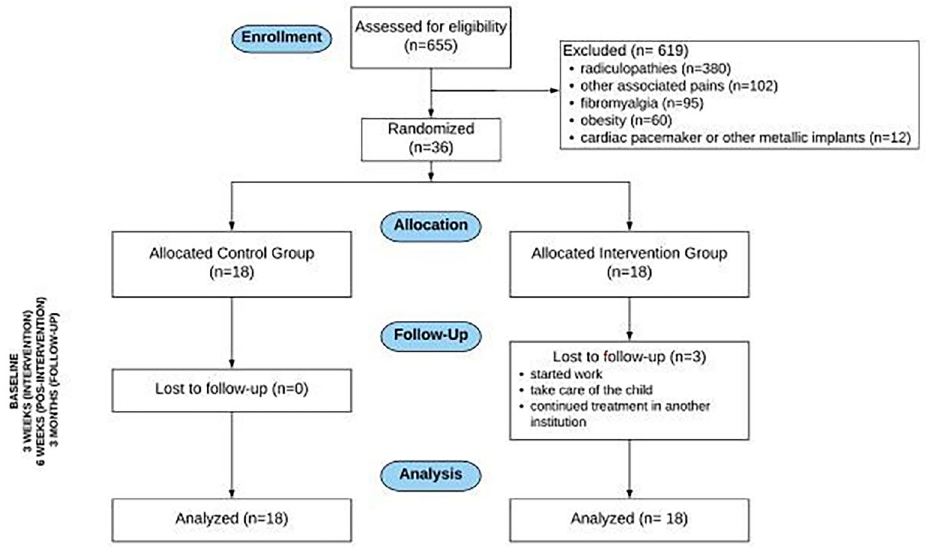
Figure 1. Consort fl owchart for enrollment, randomization, and treatment of the participants. Intervention Group: completed cases using the intention-to-treat